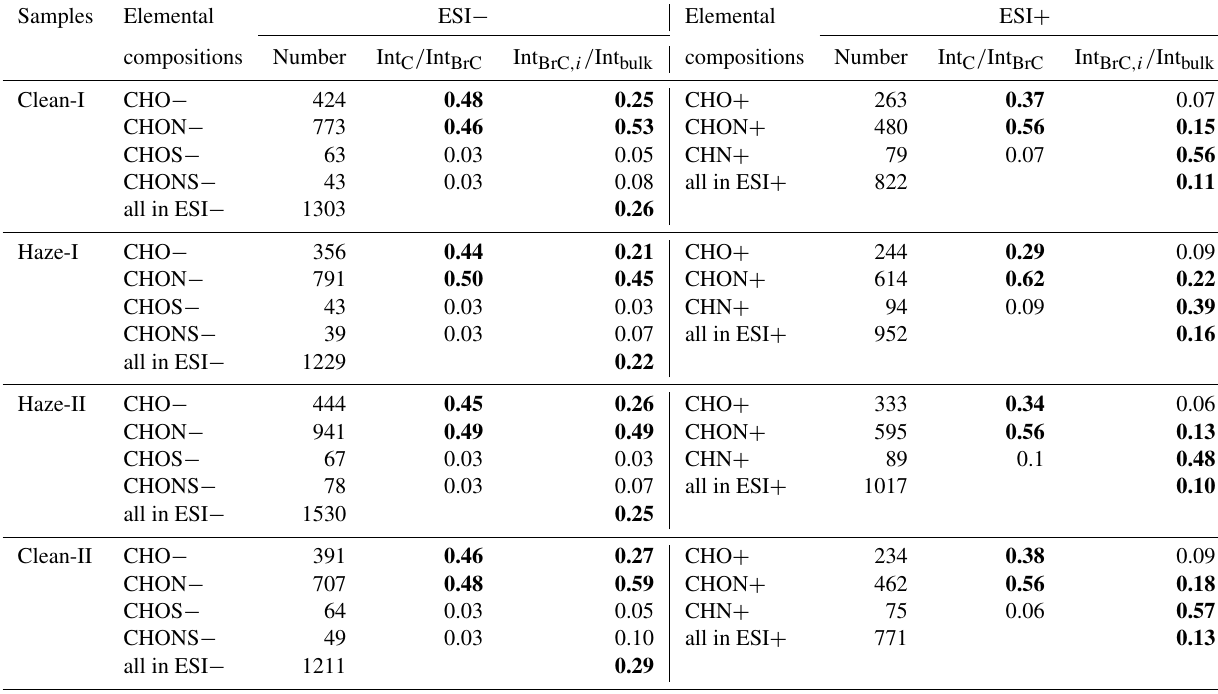
Table 1. Formula number of potential BrC chromophores and the intensity ratios of each group of potential BrC in total potential BrC and each group of total identified formulas, respectively.